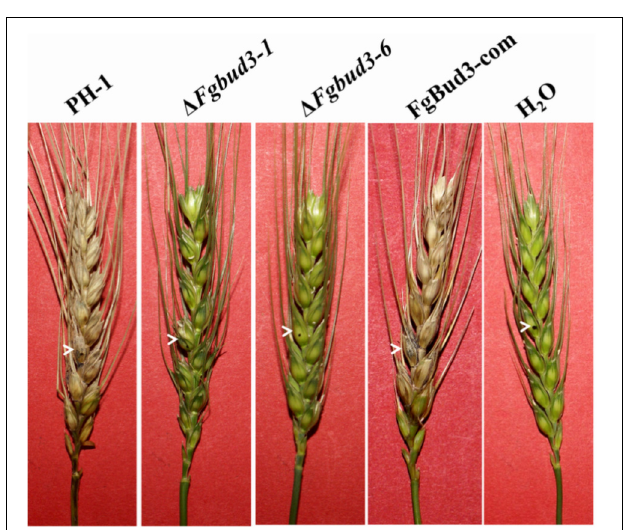
FIGURE 5 | Infection assays with flowering wheat heads. Wheat heads infected with conidia of PH-1, (cid:49) Fgbud3-1 and FgBud3-com. The arrows indicate inoculated